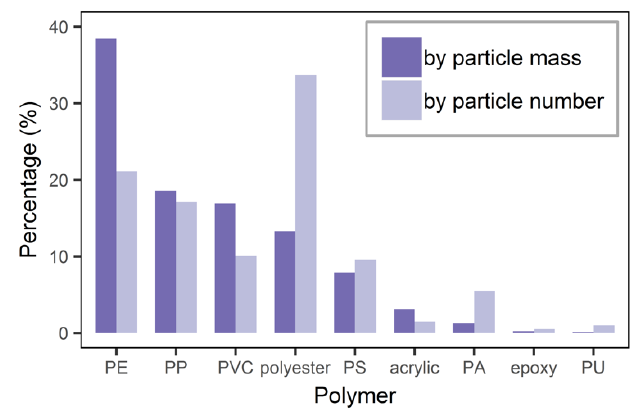
Figure 3. Polymer composition of the polymers detected in terms of the relative MP mass and MP number concentrations.